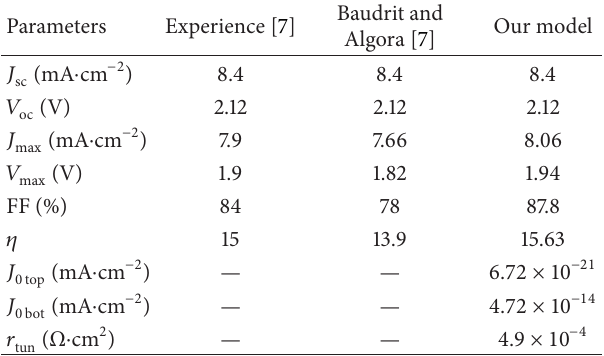
Figure 3: Experimental data (circle) and simulated (continuous line) for dual junction GaInP/GaAs. Table 1: Parameters extracted from the experience and simulation by Baudrit and Algora [7] and comparison with our extracted parameters.